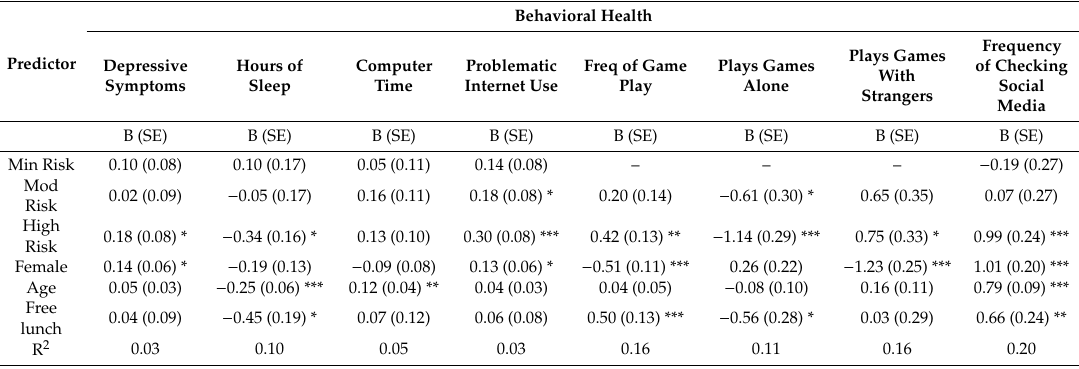
Table 2. Study 1: Gaming Risk on Adolescent Behavioral Health and Online Social